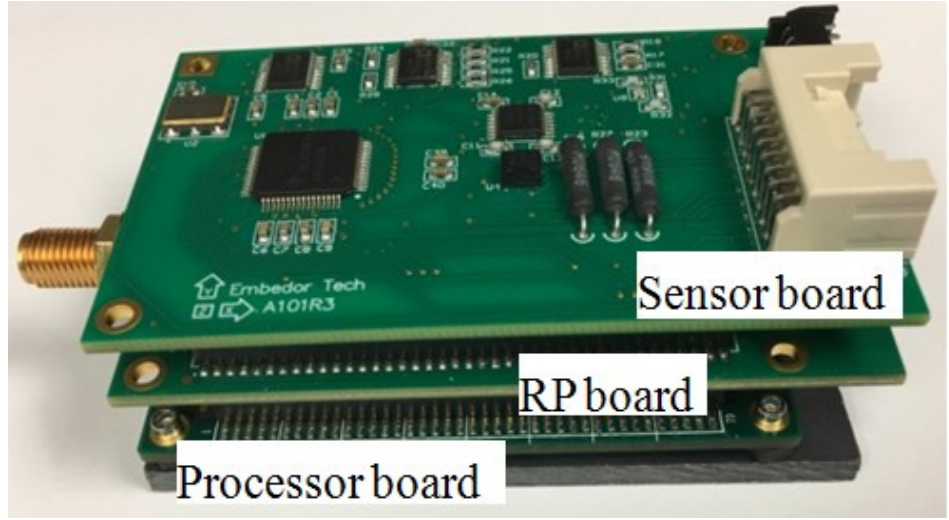
Figure 8. Xnode smart wireless sensor platform.